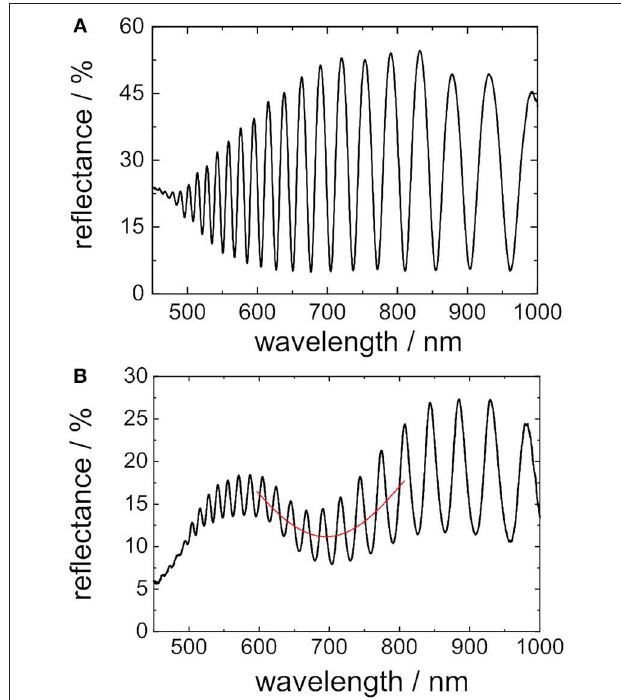
FIGURE 2 | Reflectance spectra of porous silicon films without and with gold nanostructures taken at normal incidence. (A) Spectrum of a freshly etched porous silicon film before being immersed in gold salt solution. (B) Spectrum of a freshly etched porous silicon film which has been immersed in gold salt solution for 7min - leading to the deposition of gold nanostructures on the porous silicon